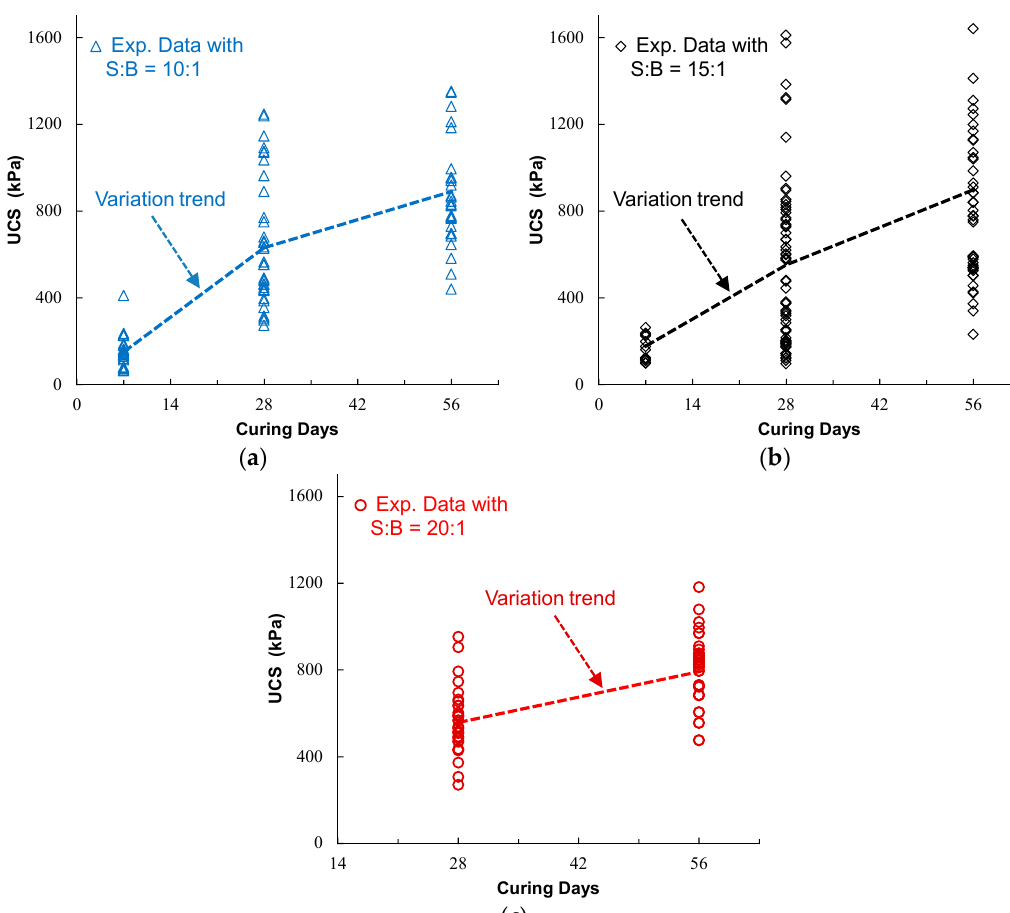
Figure 4. Variation of the UCS obtained with cylindrical samples of cemented hydraulic backfill with a constant pulp density of 72% as a function of curing days with sand (S) to binder (B) ratios (S:B) of ( a ) 10:1; ( b ) 15:1; and ( c ) 20:1, respectively (without any classification).